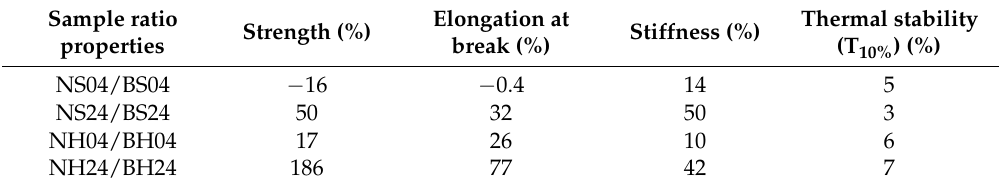
Table 5. Influence of nanoparticles on the properties of MRE compared to bare